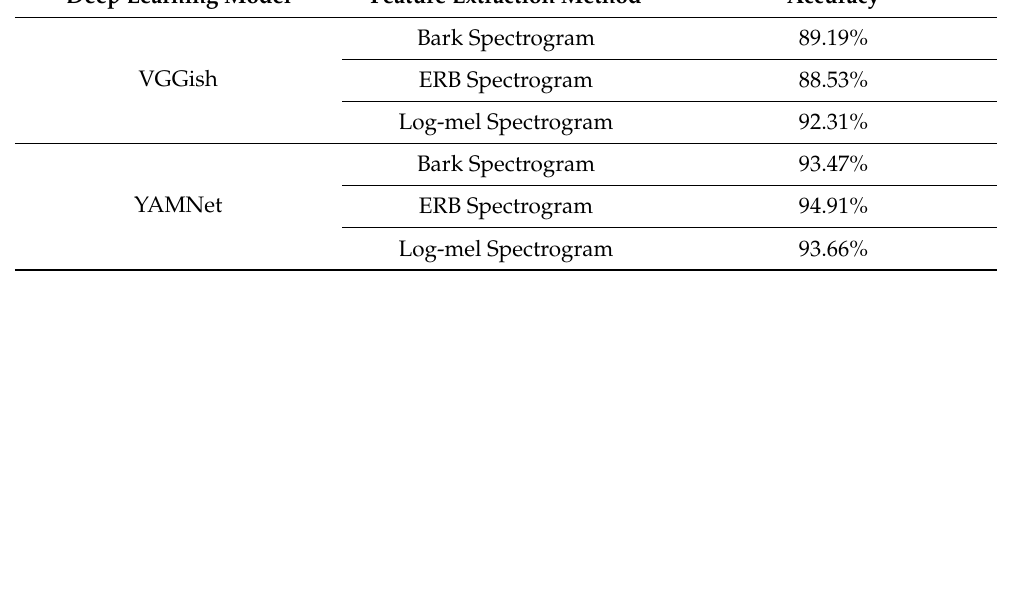
Table 5. Accuracy of CNN transfer learning model based on 2D spectrogram features.